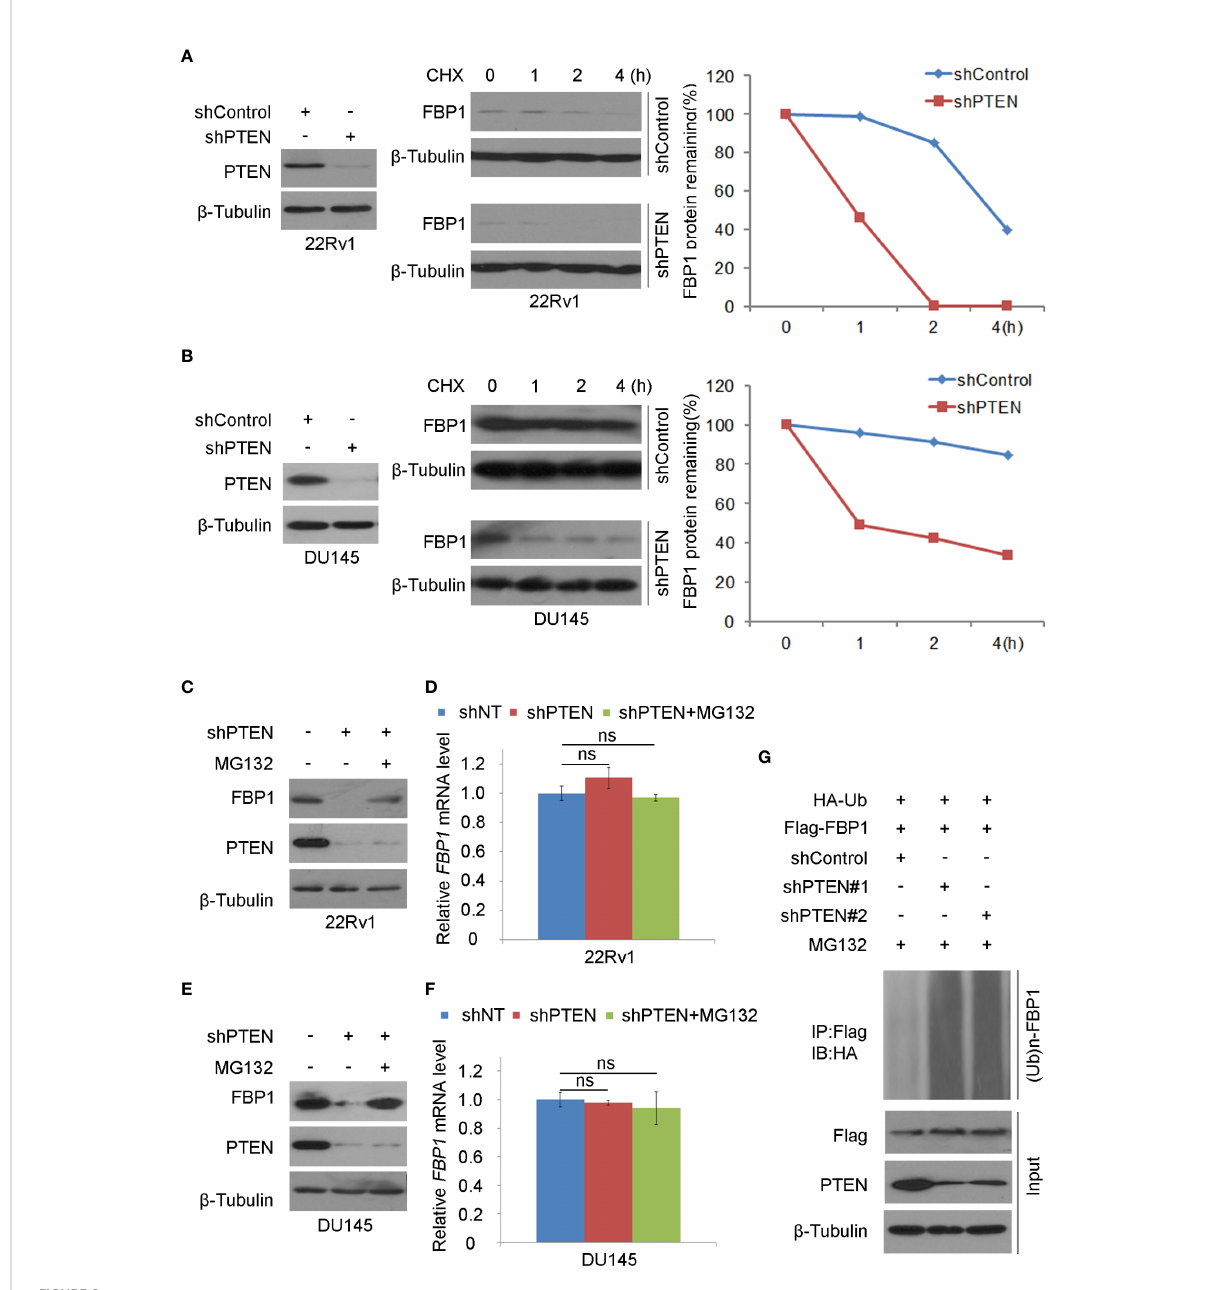
FIGURE 2 Loss of PTEN promotes FBP1 protein ubiquitination and degradation (A, B) WB and quanti fi cation of WB bands were carried out in 22Rv1 (A) and DU145 cells (B) infected with shControl or PTEN shRNAs for 48 h and followed by treatment with 50 m g/ml cycloheximide (CHX) for speci fi c intervals of time. At every time point, the level of FBP1 protein was normalized to the level of b -Tubulin (a WB loading control) fi rst and then to the value at the 0-h time point. (C, D) WB (C) and RT-PCR (D) were performed in 22Rv1 cells infected with lentivirus expressing control or PTEN shRNAs for 48 h and further treated with MG132 at 20 m M for 12 hours. All quantitative data are shown as Mean ± SD (n=3). Student ’ s t test. n.s., not signi fi cant. (E, F) WB (E) and RT-PCR (F) were conducted in DU145 cells infected with lentivirus expressing control or PTEN shRNAs for 48 h and exposed with MG132 at 20 m M for another 12 hours. All quantitative data are shown as Mean ± SD (n=3). Student ’ s t test. n.s., not signi fi cant. (G) WB evaluation was carried out using whole-cell lysate and co-IP samples obtained in 293T cells transfected with the indicated constructs and further treatment with 20 m M of MG132 for 12 more